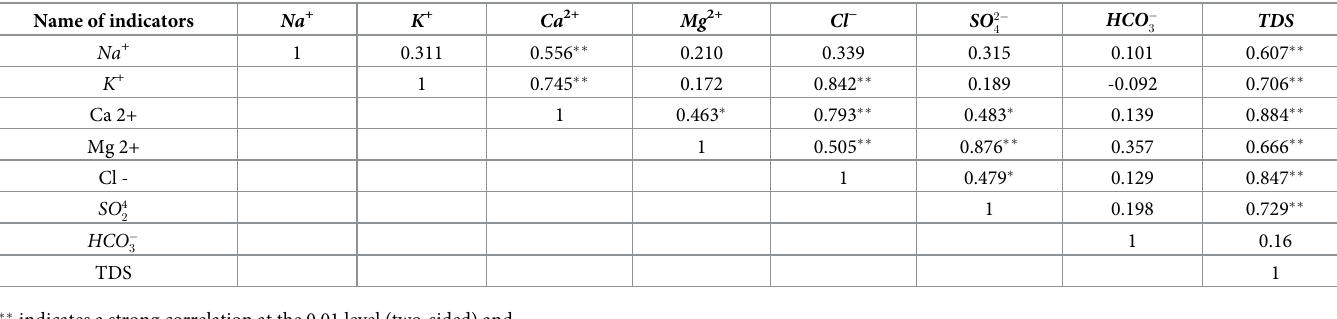
�� indicates a strong correlation at the 0.01 level (two-sided) and � indicates a strong correlation at the 0.05 level (two-sided).